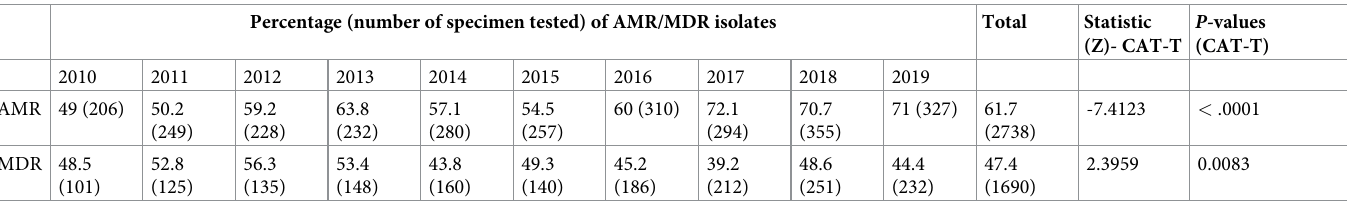
Table 3. Trends in antimicrobial resistance and multidrug resistance among Escherichia coli isolated from dog specimens at the Indiana Animal Disease Diagnostic Laboratory, 2010–2019.